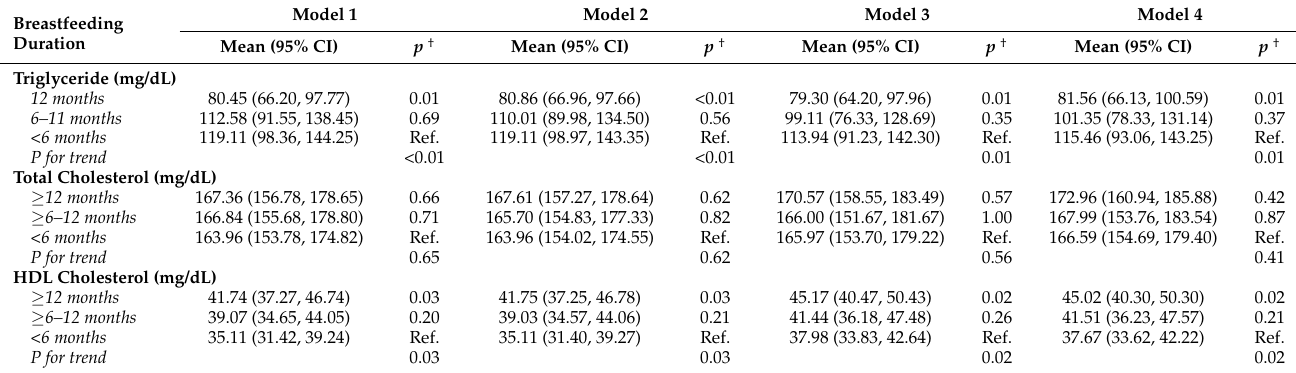
Table 2. Exponentiated marginal means * of 12-month postpartum lipids by breastfeeding duration among 79 MADRES